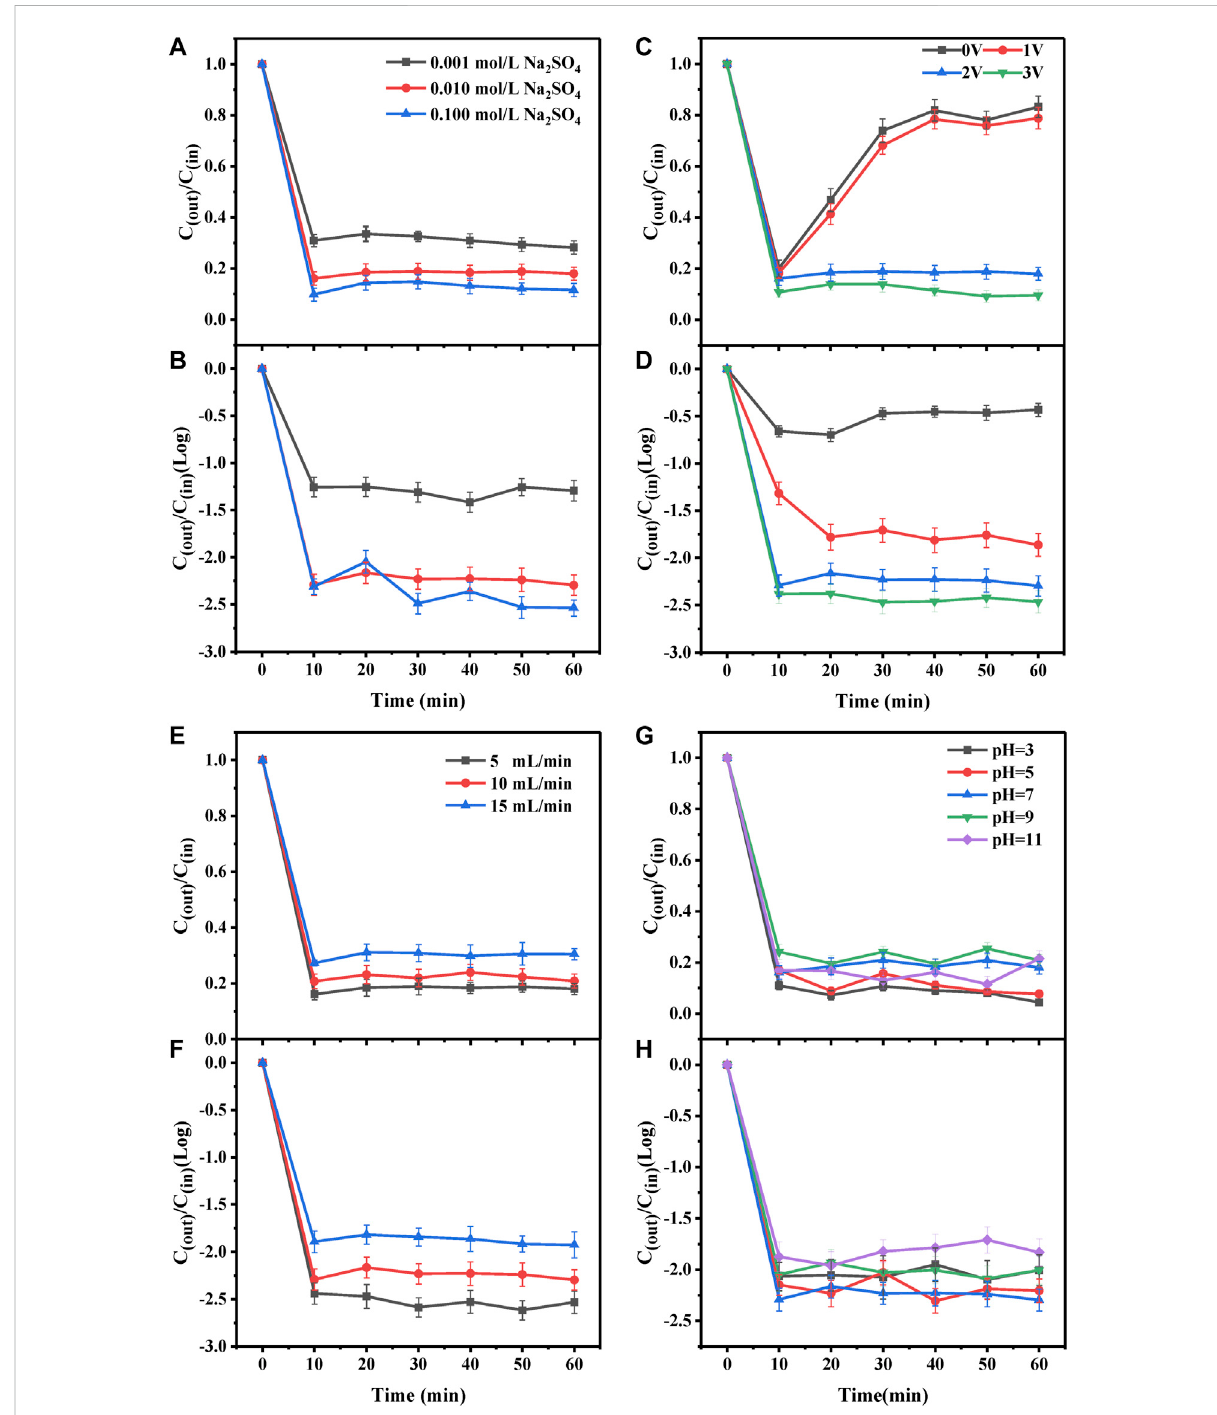
FIGURE 3 Effectof (A) – (B) electrolyteconcentration (C) – (D) anodevoltage (E) – (F) fl owrateand (G) – (H) pHonthedegradationofantibioticsandARGsby the electrochemical CNTM-COOH